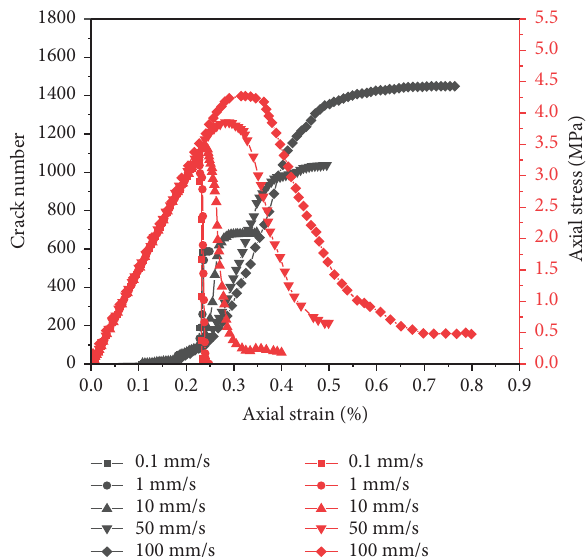
Figure 10: Crack evolution and stress variation